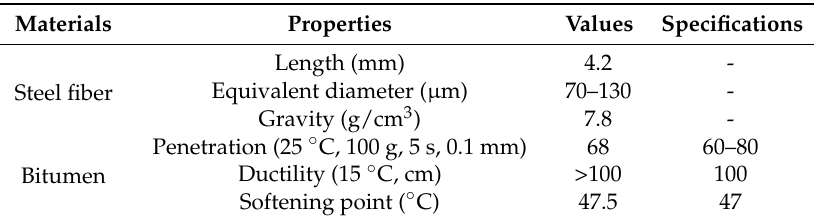
Table 1. The properties of asphalt binder and steel wool